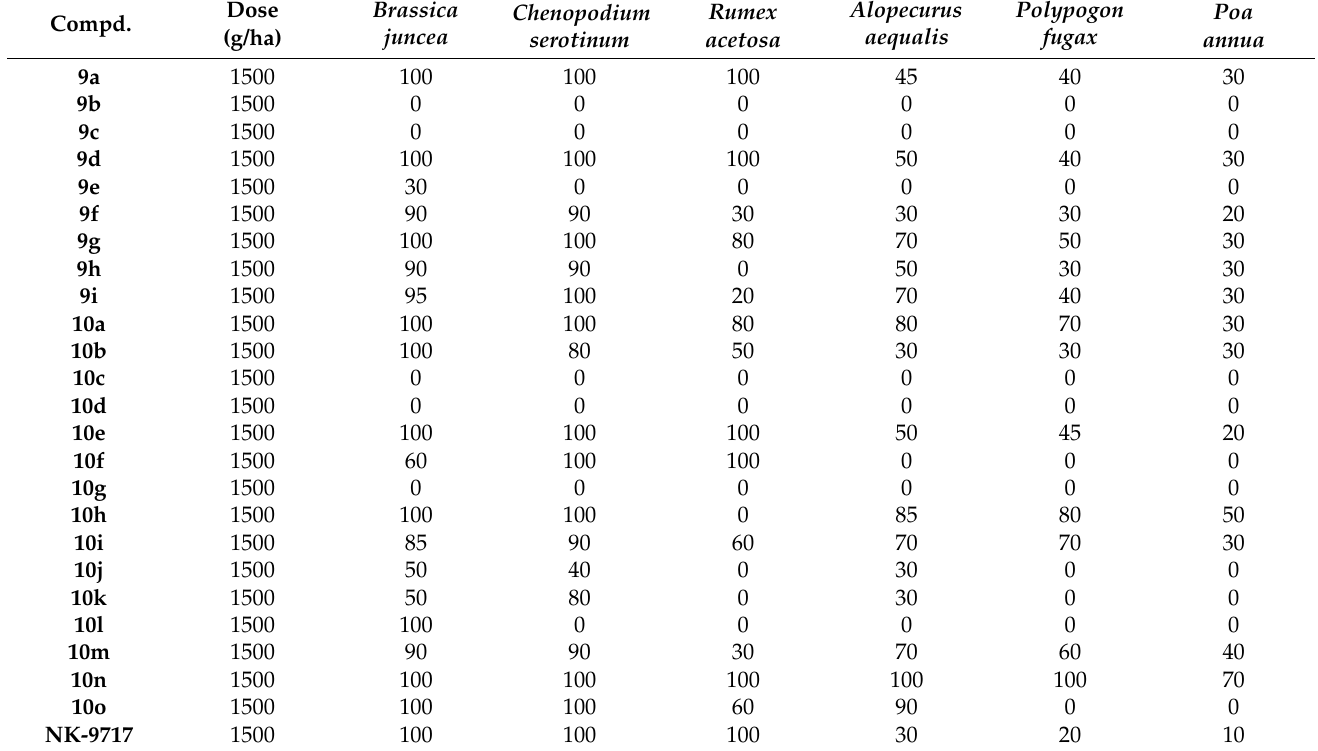
Table 1. Herbicidal activity(inhibition rate, %) of title compounds at 1500 g/ha. Compd.